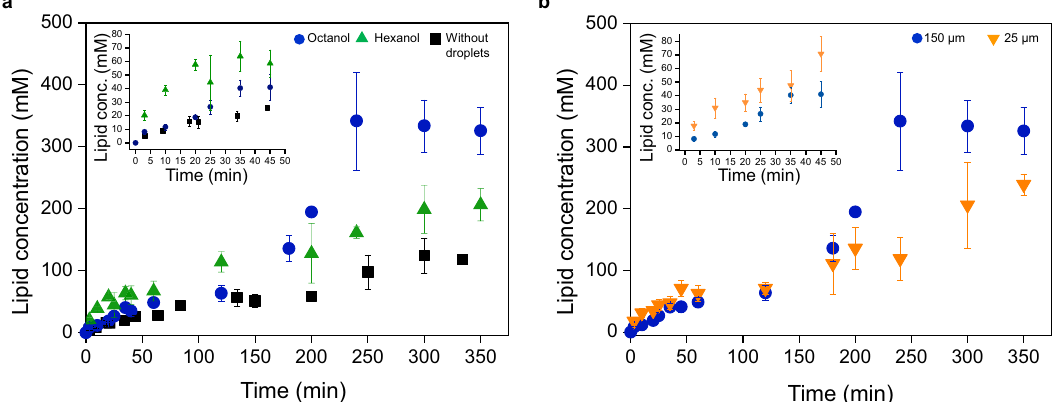
Fig. 4 Reciprocity in the coupling between lipid reproduction and droplet motility. a Formation of lipid 1 in an oil-in-water emulsion of MPC (1.1 eq.), Cs 2 CO 3 (0.2 eq.) and hexanethiol (1 eq.). The kinetics are reported in the presence of motile droplets (150 µ m, circle), in the presence of stationary droplets of hexanol (~132 µ m, triangle) and in the absence of droplets (square). Each point corresponds to an average of three experiments, and the error bars indicate standard deviation. b Formation of lipid 1 in the presence of 150 µ m octanol droplets (circle) and 25 µ m octanol droplets (inverse triangle). Each point corresponds to an average of three experiments, and the error bars indicate standard